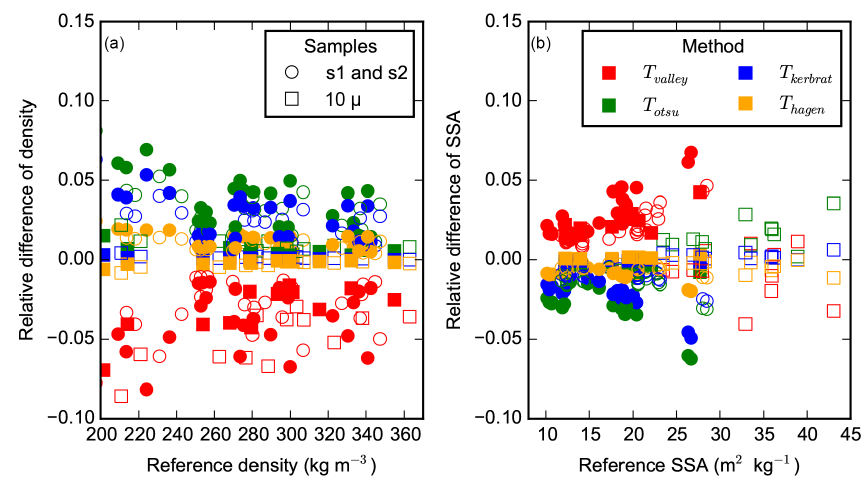
Figure 10. Sequential filtering segmentation: relative variation of density (a) and SSA (b) computed with different threshold determina- tion methods, with respect to the reference values computed with T mask . Void (solid) markers correspond to values obtained without any smoothing (with a Gaussian filter of standard deviation σ = 1 voxel). The legends apply to both subplots.